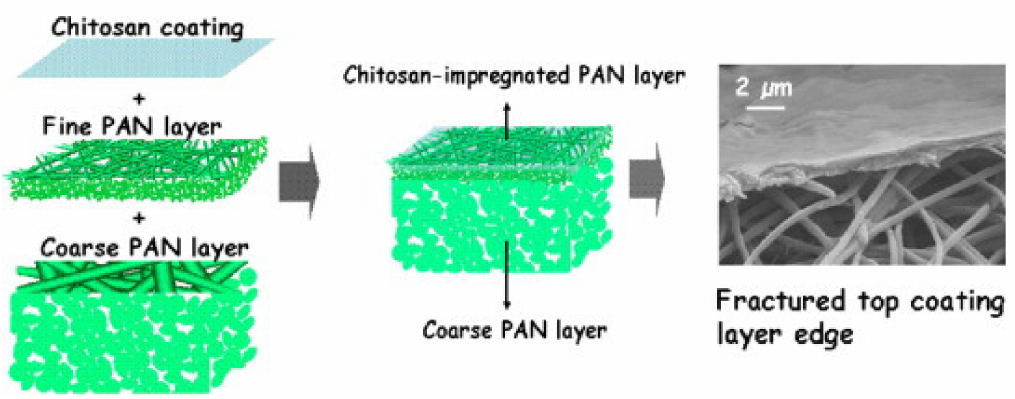
Figure 2. An example of a composite nanofiber membrane consisting of an electrospun polyacrylonitrile (PAN) layer coated with a chitosan layer. Reprinted from [42] with permission from Elsevier.